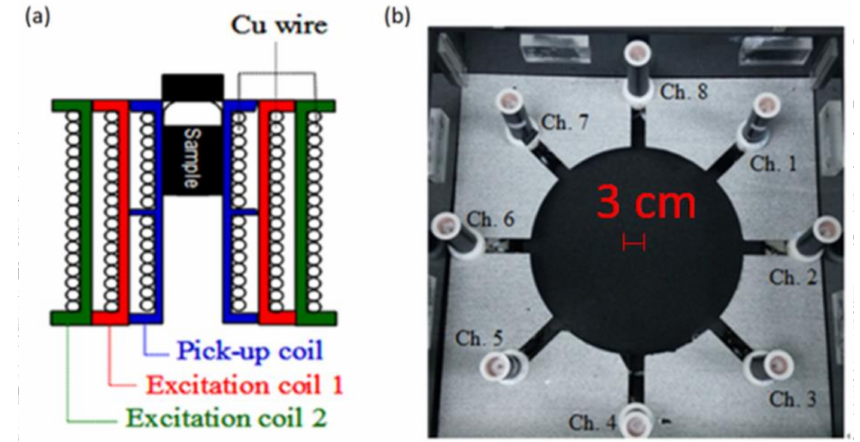
Figure 2. The eight channels of pick-up coils: ( a ) Assembly of one set of coils and ( b ) array of eight coil